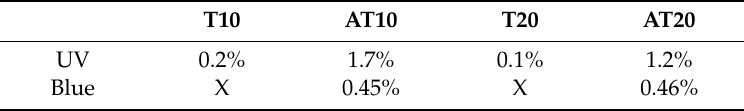
Table 1. The response ((I L − I d ) / I d ) of light for 50 s light